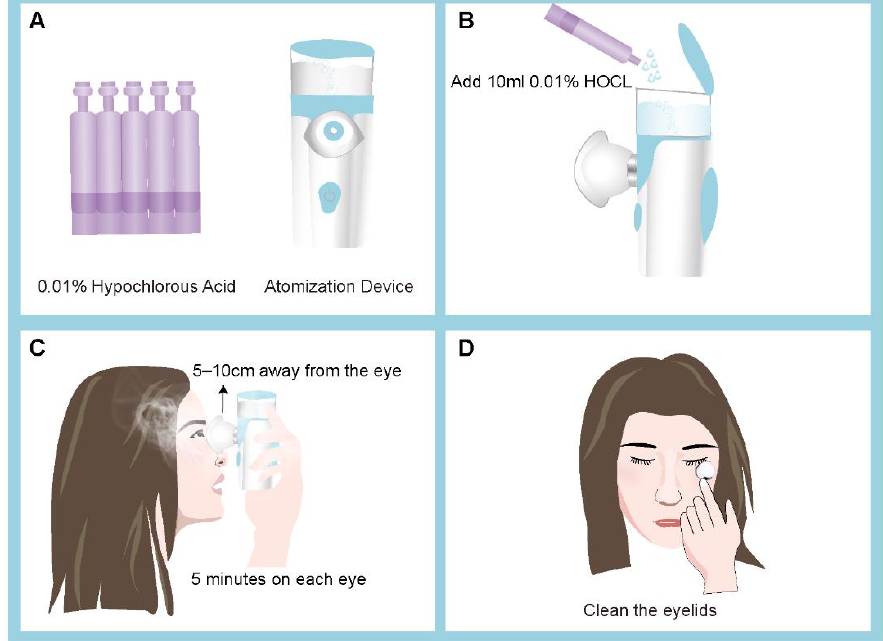
Figure 1. The portable atomization device and how it is used on a patient. Illustration of using 0.01% hypochlorous acid (HOCL) via an atomization device ( A,B ), which can be easily sterilized with alcohol wipes. Patients with blepharitis using 0.01% HOCL through ultrasonic atomization for treatment ( C,D treatment ( C,D ).